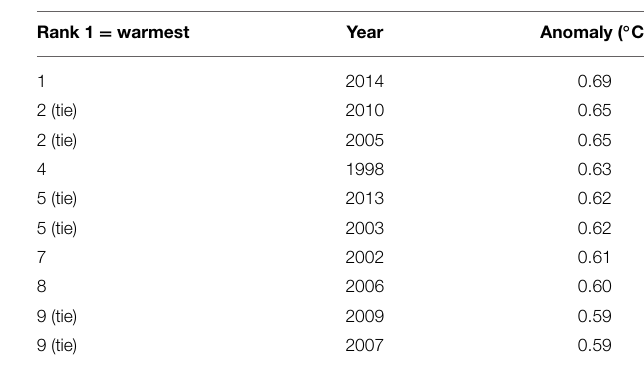
TABLE 2 | List of the 10 warmest years between 1880 and